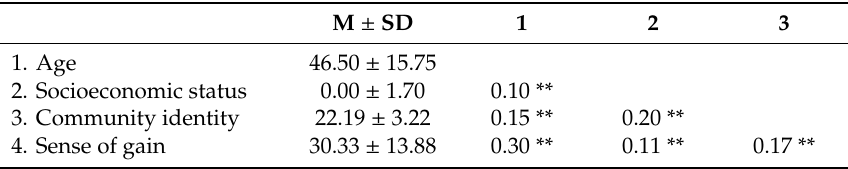
Table 2. Correlations among central study variables.